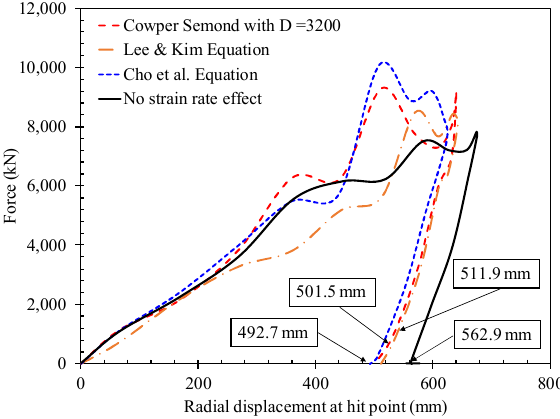
Figure 7. Force- radial displacement curves with various strain-rate hardening definitions.